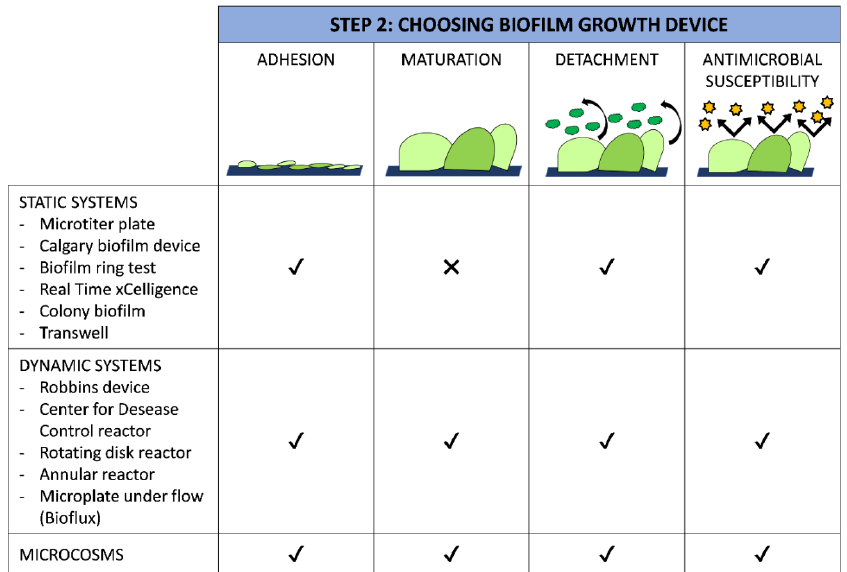
Figure2. Figure 2. Scheme representing the second step in the experimental procedure for testing new anti-